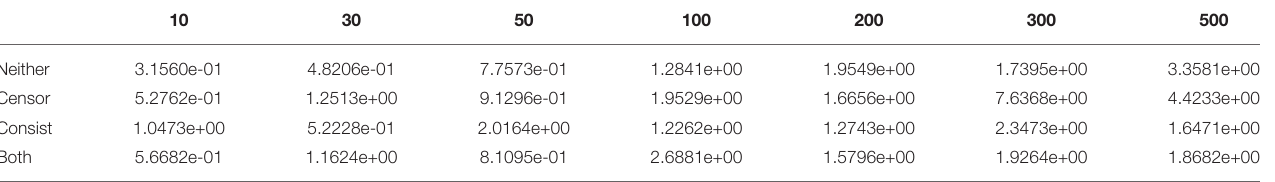
TABLE 6 | Ablation test on